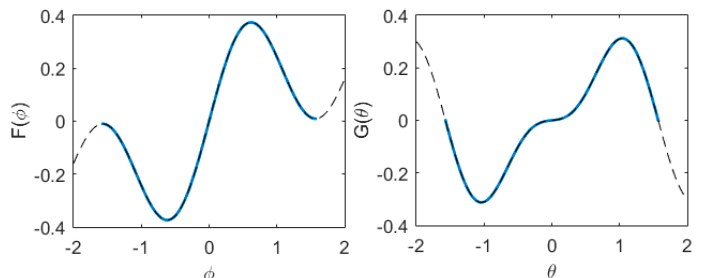
Figure 2. Numerically integrated values ( − ) and Fourier series values (–) of F ( φ ) ( left ) and G ( θ ) ( right ) of the fourth order orientation tensor component a 1123 . Orientation distribution function (ODF) standard deviation σ = 0.1 ra .